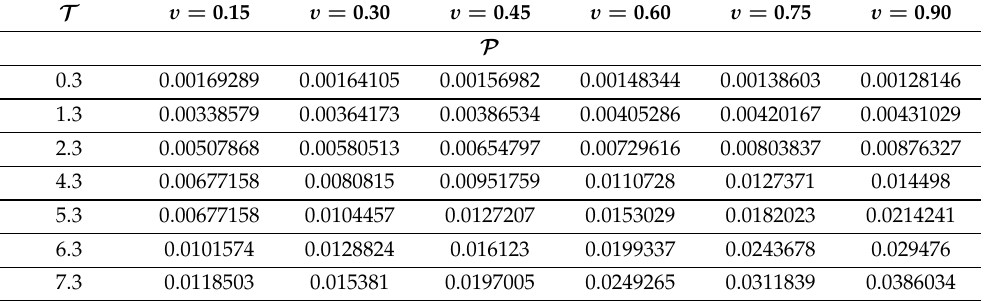
Table 1. The impact of fractional order ( υ ) on the condition P given by